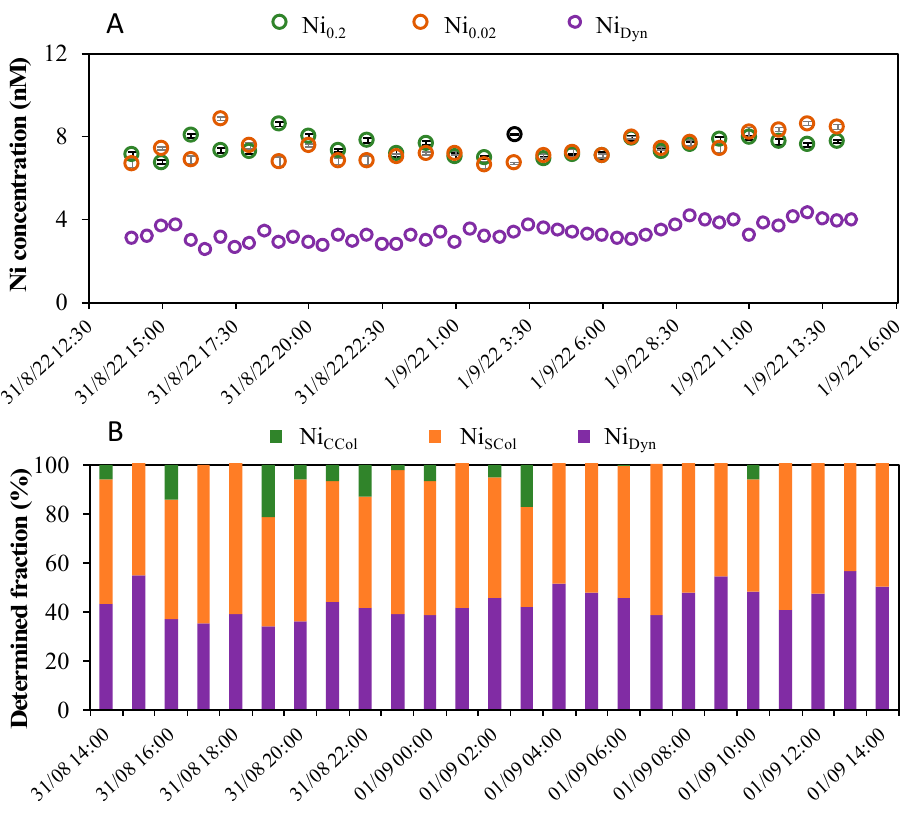
Figure 7. ( A ) Variations of the dissolved Ni(II) concentrations in the filtered 0.2 (green) and 0.02 (orange) µ m fractions and the Ni-nioxime concentration (violet), and ( B ) variations of the Ni speciation during the 24h cycle recorded at a 6m depth from LeXPLORE platform in Lake Geneva.